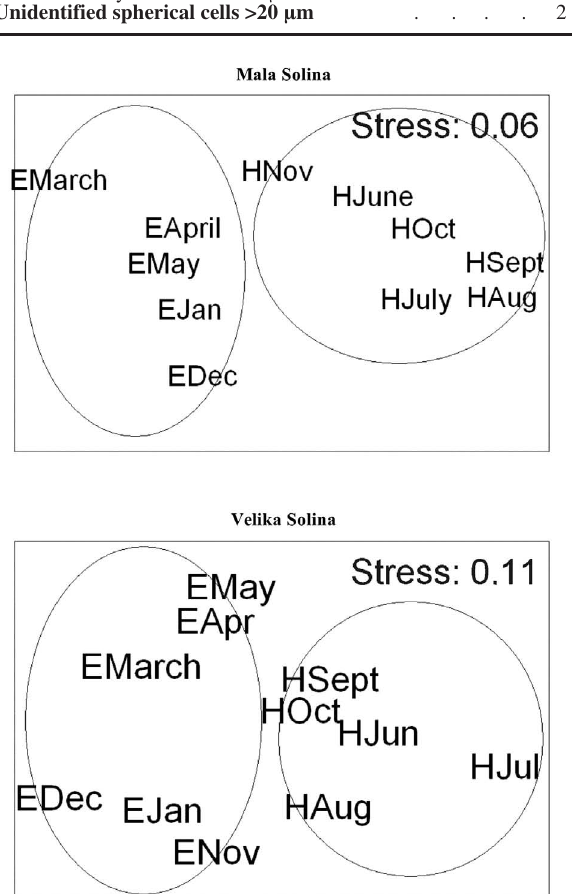
Fig . 7. – MDS ordination of phytoplankton composition and abun-– MDS ordination of phytoplankton composition and abun- MDS ordination of phytoplankton composition and abun- dance based on the Bray-Curtis similarity matrix in Mala Solina (stress value = 0.06, ANOSIM, p < 0.01) and Velika Solina (stress value = 0.11, ANOSIM, p < 0.05). Symbols E (euhaline) and H (hyperhaline) refer to the two groups of significantly different phy- toplankton communities.